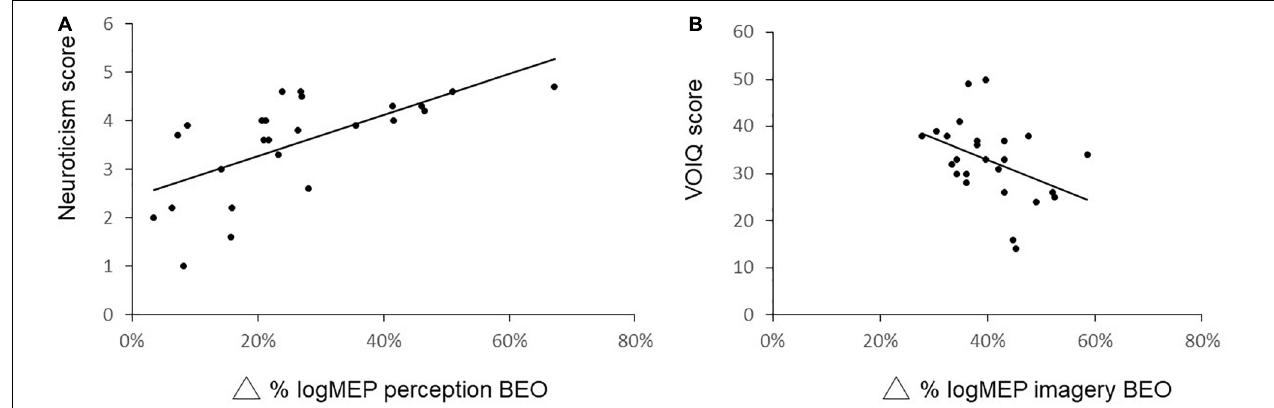
FIGURE 4 | Correlation analysis between changes in logMEP amplitude after perception of BEO and Neuroticism score (A) and changes in logMEP amplitude after odor imagery and vividness of olfactory imagery questionnaire (VOIQ) score (B) . Lower VOIQ scores indicate better imagery ability.